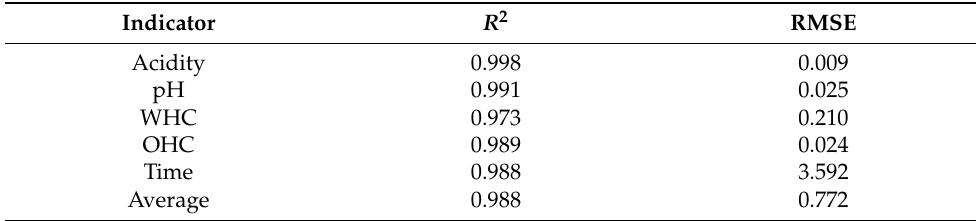
Table 3. Individual and average regression coefficients for the training and testing lots.